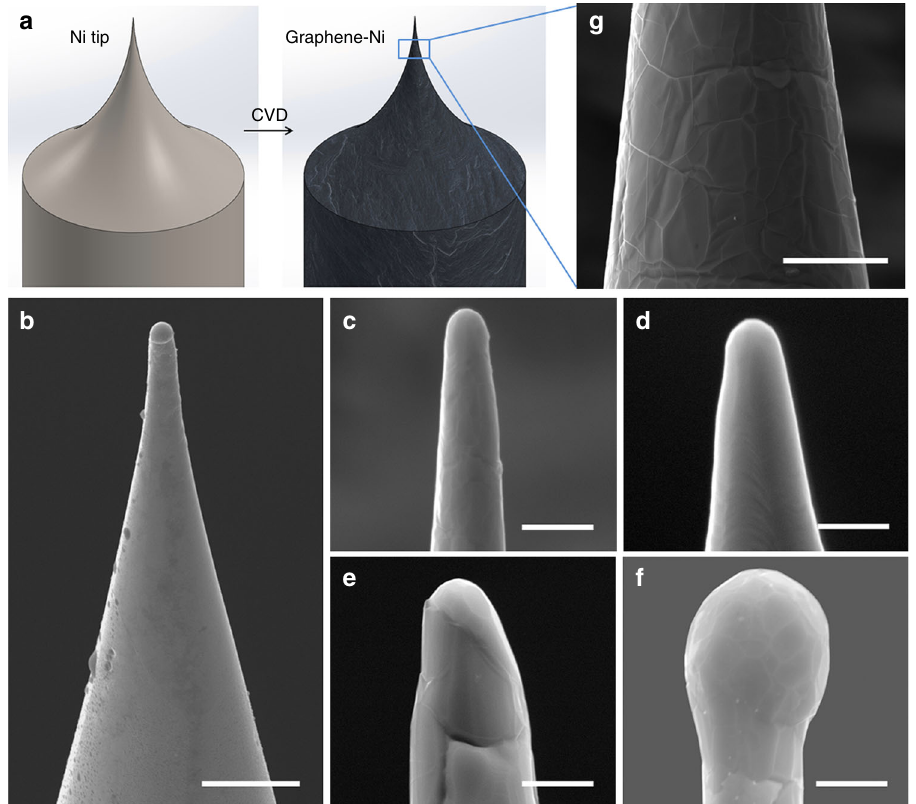
Fig. 1 SEM characterization of the Graphene-Ni fi eld emitter. a Illustration of the fabrication of a graphene-coated point cathode. b SEM images of as- etched Ni tip from electrochemical etching at low magni fi cation showing supporting wire (scale bar, 5 µ m), and SEM images of graphene-coated point cathodes of different tip radii: c 210 nm, d 300 nm, e 480 nm and f 800 nm. Scale bar ( c , d , e , f ), 1 µ m. g SEM image of the lateral surface of the